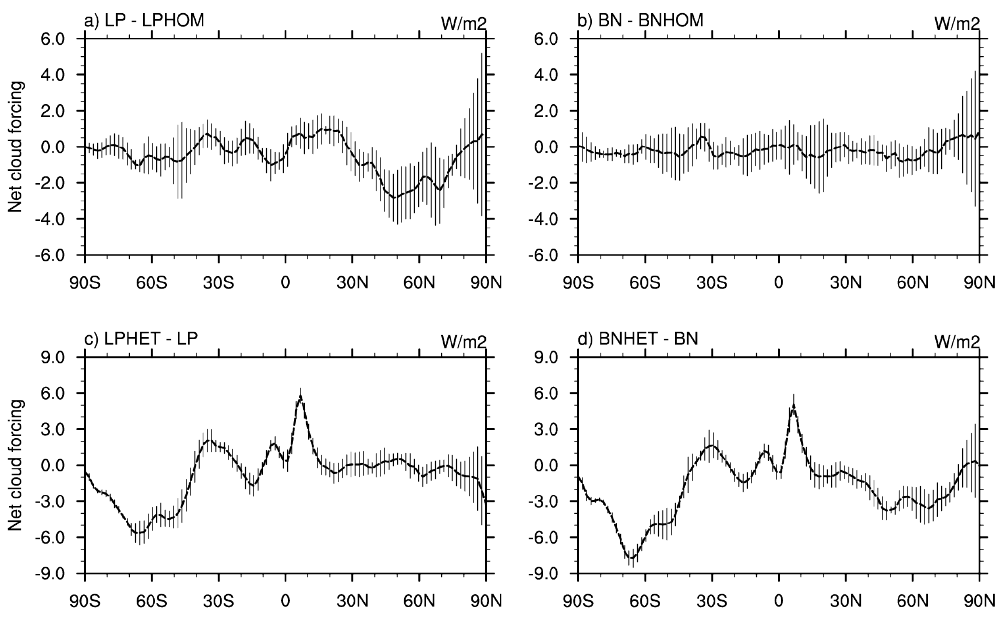
Fig. 10. Annual and zonal mean distributions of net cloud forcing (CF) differences between combined and pure homogeneous nucleation simulations (upper) and between pure heterogeneous and combined nucleation simulations (lower) with LP05 (left) and BN09 (right) parameterizations. The vertical bars overlaid on solid lines depict the ranges of the two standard deviations (2 σ ) estimated from the CF differences of each of 5 years at different latitudes.